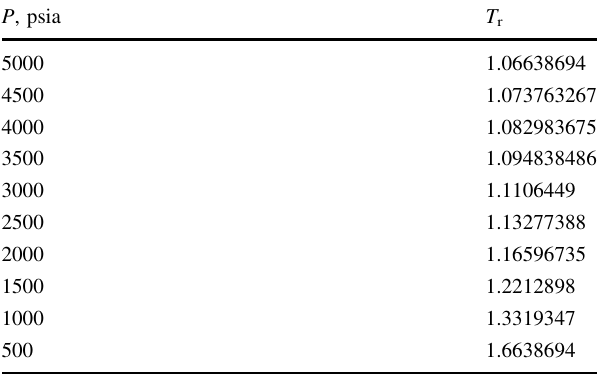
Table 3 Transmissibility multiplier as ROCKTABLE input